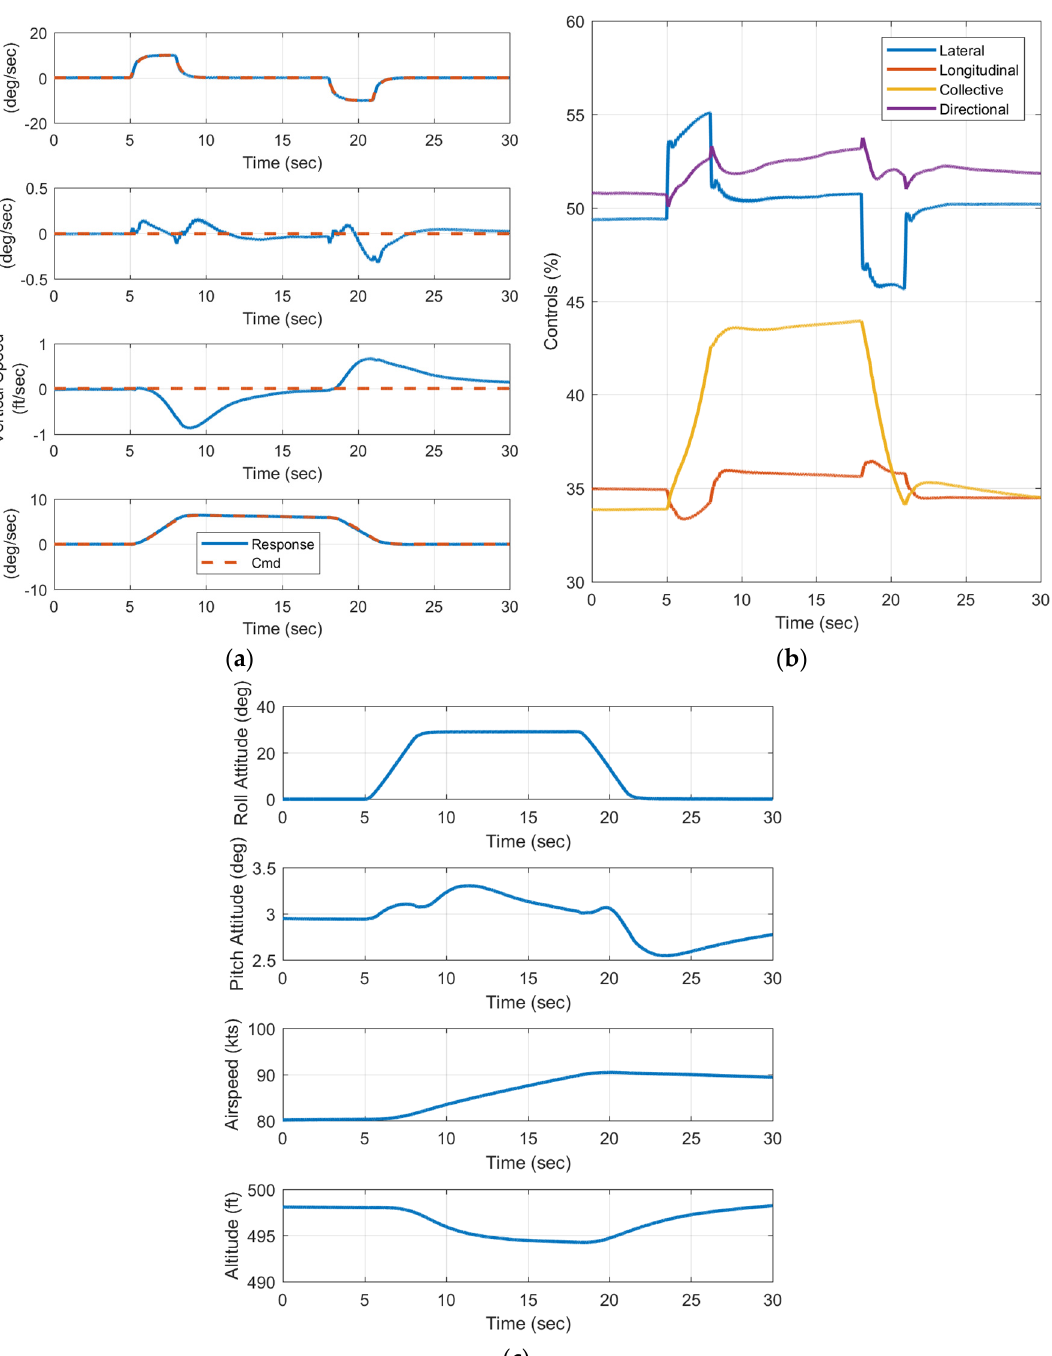
Figure 12. Time history response for a 30° banked turn maneuver, ( a ) tracking of DI-controlled variables; ( b ) actuator activity; ( c ) attitude, airspeed, and altitude response.